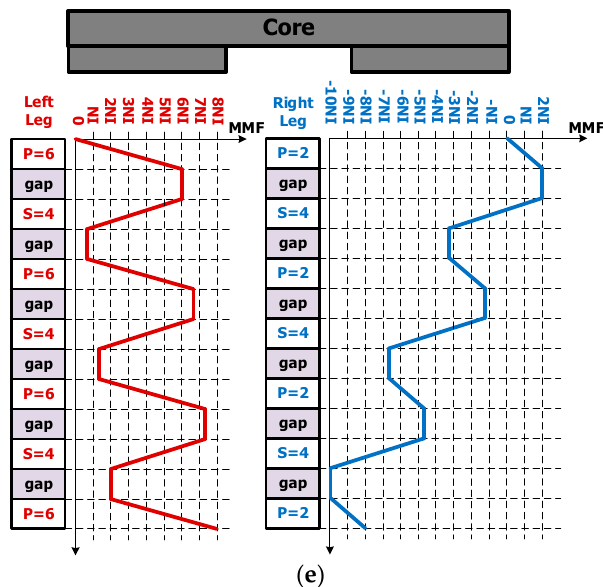
Figure 13. MMF distribution map of different numbers of windings: ( a ) Np = 16, Ns = 12; ( b ) Np = 20, Ns = 15; ( c ) Np = 24, Ns = 18; ( d ) Np = 28, Ns = 21; and ( e ) Np = 32, Ns = 24.